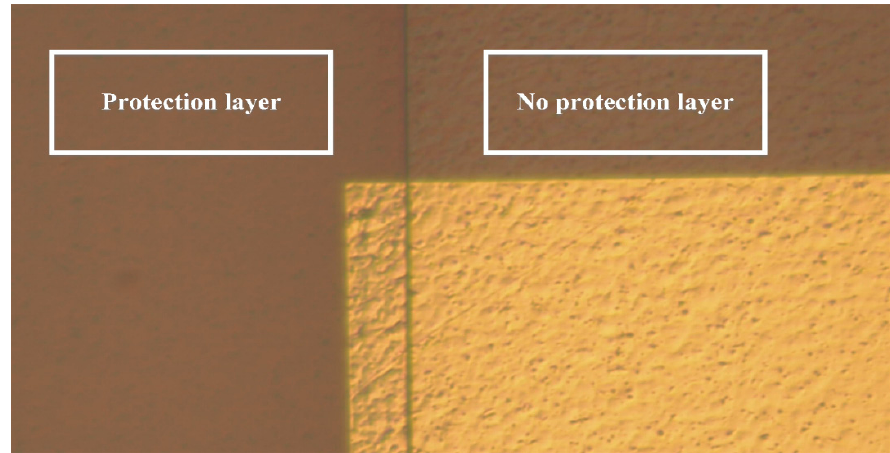
Figure 5. Optical microscope photo of the protective layer.